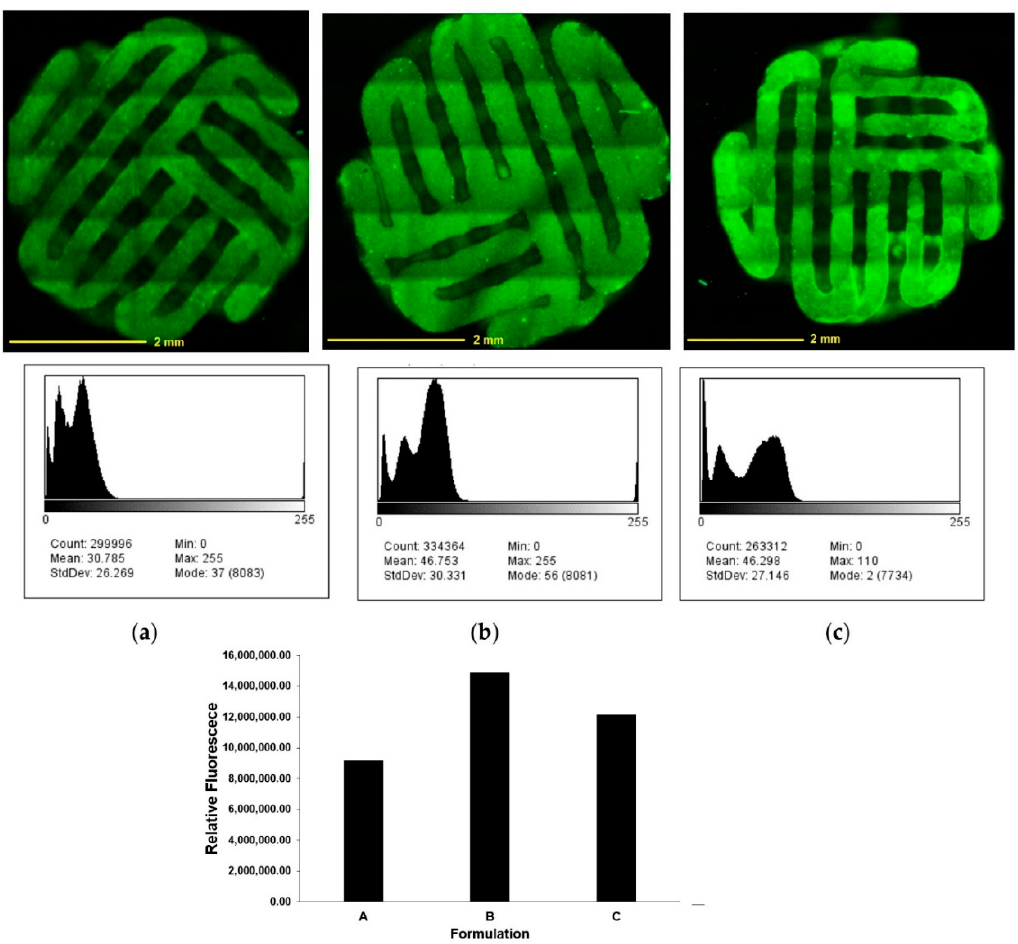
Figure 4. Confocal microscopic images of drug solution coated scaffolds with ( a ) F1, ( b ) F2, and ( c ) F3 (top panel), histograms showing intensity profiles as a function of fluorescence distribution (mid and lower panel).